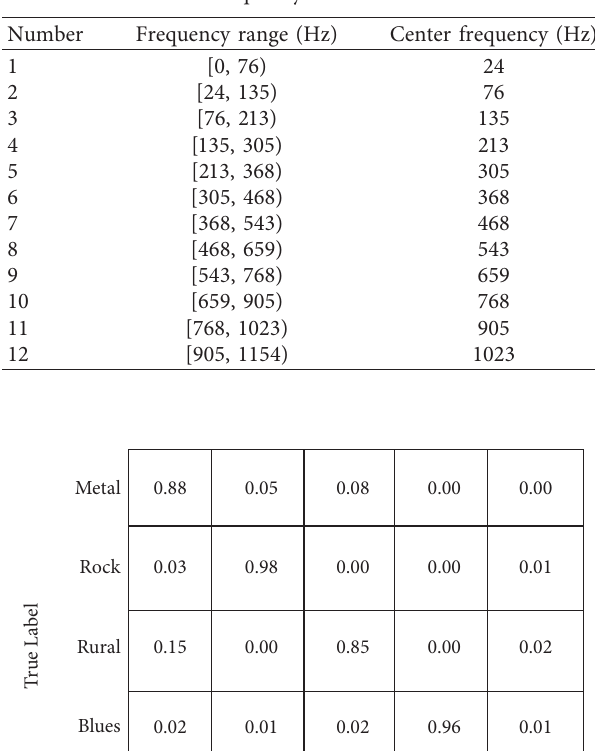
Table 2: Frequency index of Mel filter.